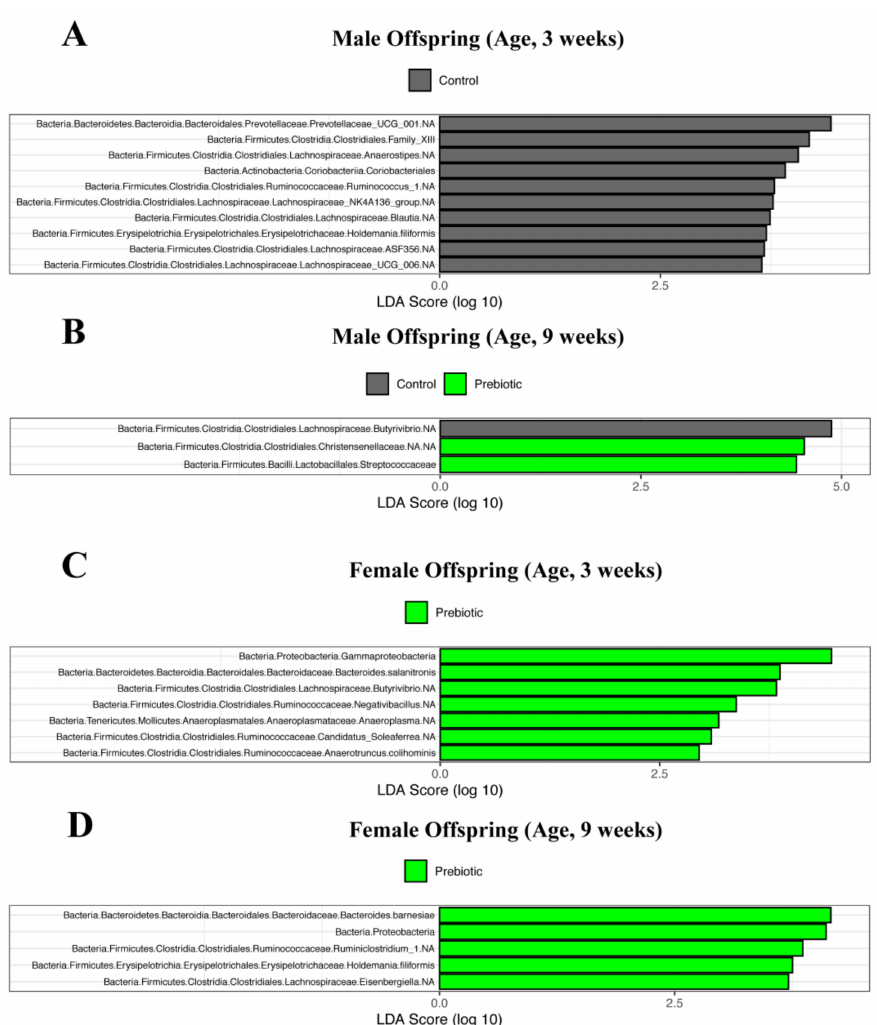
Figure 5. Fecal microbiota comparisons using a LEfSe tool of male and female offspring sired from fathers fed prebiotic or control diets for 9 weeks. ( A ) male offspring at 3 weeks of age, ( B ) male offspring at 9 weeks of age, ( C ) female offspring at 3 weeks of age, ( D ) female offspring at 9 weeks of